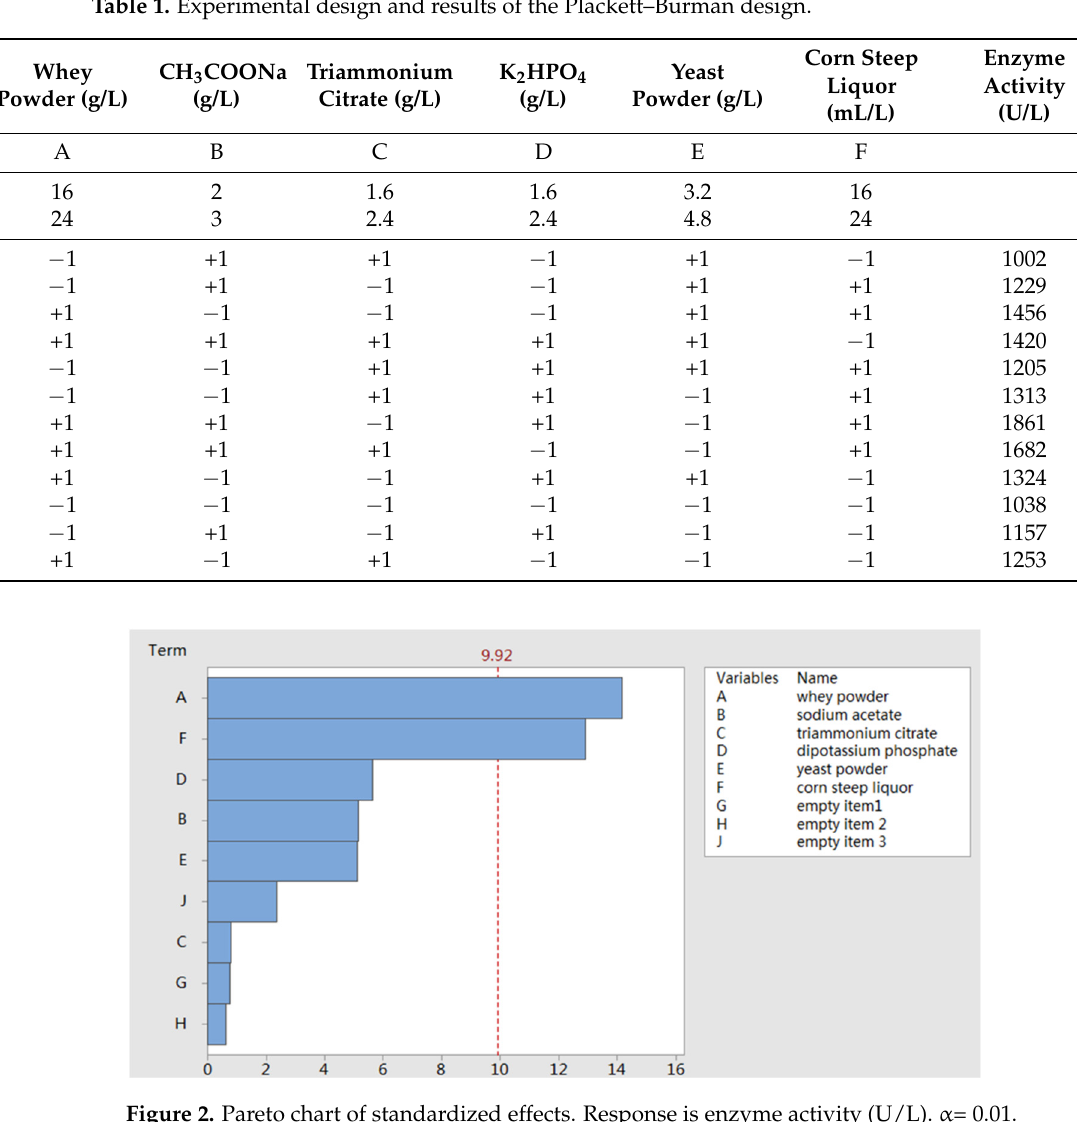
Table 1. Experimental design and results of the Plackett–Burman design.